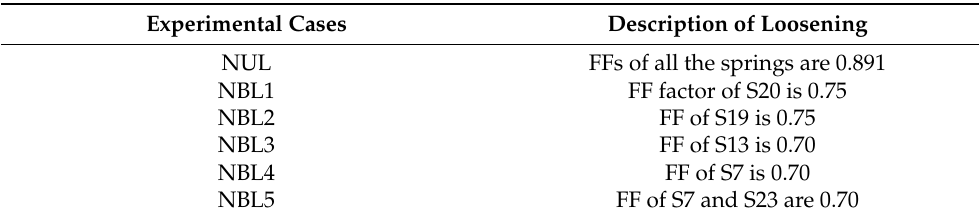
Table 8. Arrangement of the numerical synthetic data for training, validation, and testing.